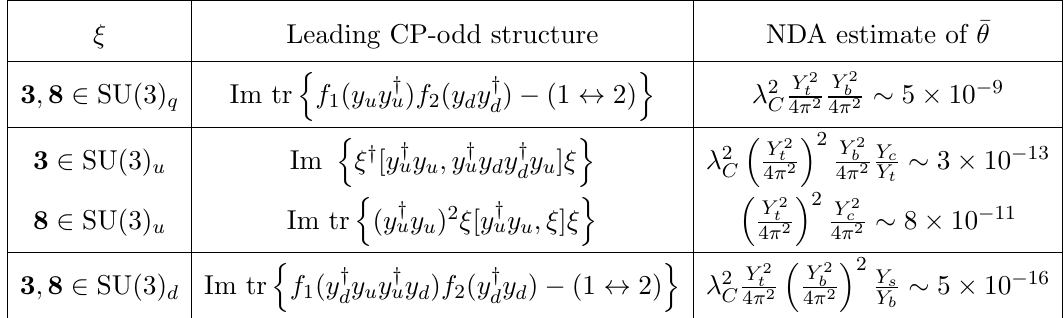
CP-odd parameter (cid:24) . In general (cid:24) carries some spurious charge under the SM (cid:13)avor group.